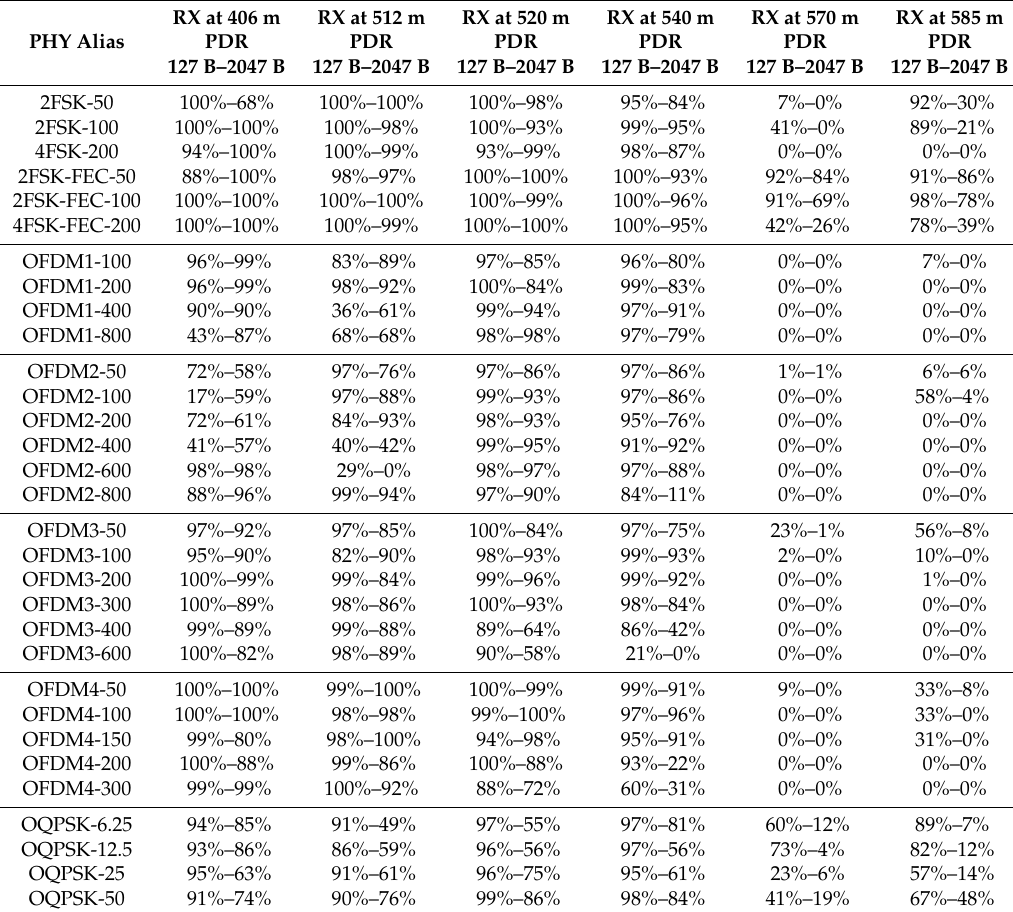
Table 9. Urban Canyon. PDR for packets of 127 B and 2047 B for each RX node, for node locations from 406 m to 585 m. Up to 520 m, all radio settings present a PDR over 50%. PDR of high data rates decay at 540